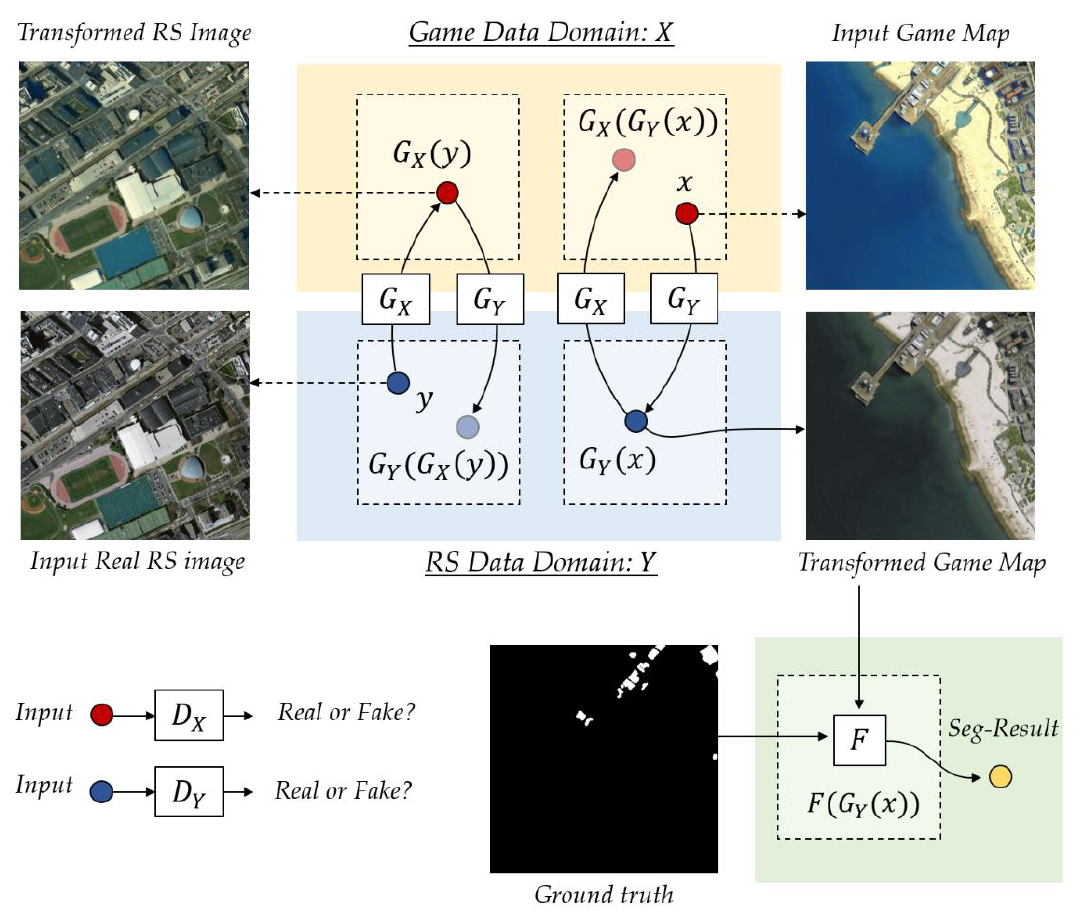
Figure 2. An overview of the proposed method. Our method consists of five networks: G X , G Y , D X , D Y and F . The former four networks, which corresponds to a CycleGAN model [26], learn two mappings between the game domain X and the remote sensing domain Y ( G X : Y → X , G Y : X → Y ). The last network F learns to predict building masks of the transformed data. In our method, we first transfer the style of a synthetic game map x to a real one G Y ( x ) and then train the network F based on the transformed image G Y ( x ) (input) and the game map legend (ground